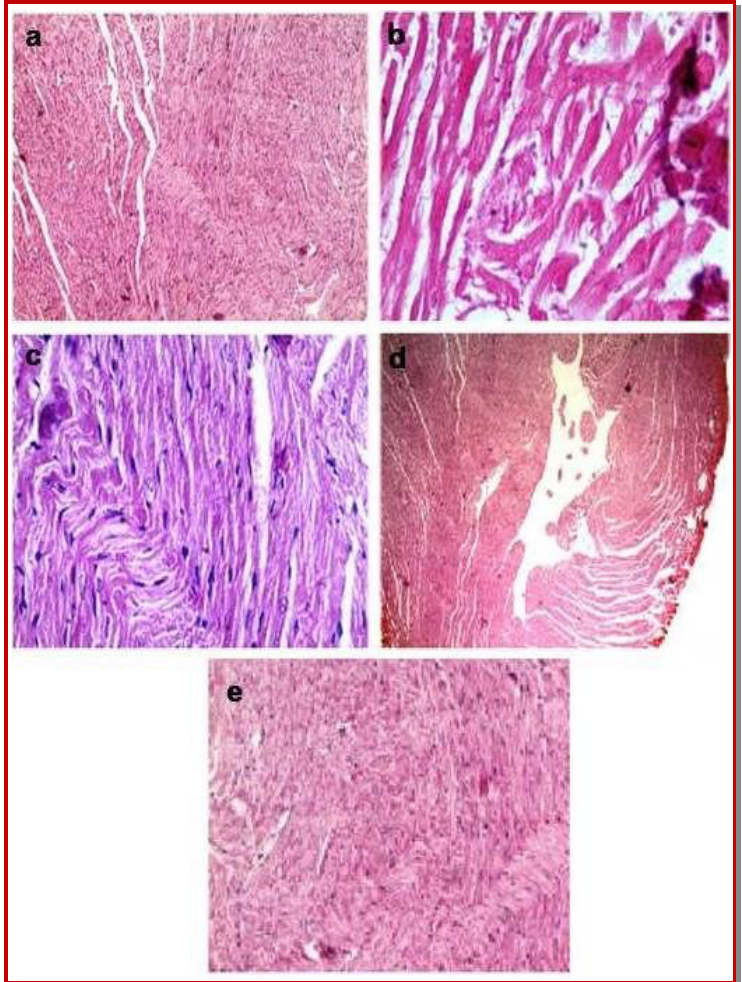
Figure 4: Histological section showing the effect of paeonol restored the normal myocardial architecture. Marked alterations in the myocytes and shrunken nuclei observed in cardiac tissues of diabetes-induced rats (b) as compared to normal control (a). These aberrant alterations were effectively restored on paeonol treatment (c-e). Paeonol treatment normalised the orientation of the car- diac fibrils and reduced fibrosis of the myocardium. (a) Control; b) streptozotocin ; c) 50 mg paeonol + streptozotocin ; d) 100 mg pae- onol + streptozotocin ; e) 200 mg paeonol + streptozotocin